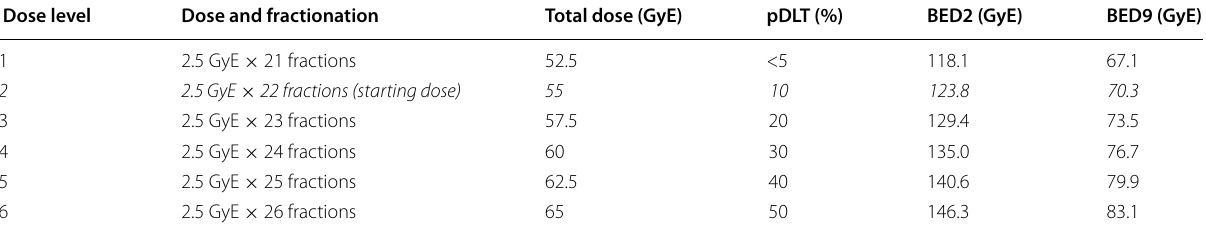
The starting dose of the trial is at 2.5 GyE 22 (in italics) × CIRT carbon-ion radiotherapy, GyE gray equivalent, pDLT probability of dose-limiting toxicities, BED biological effective dose, BED2 cumulative BED with an α/β ratio of 2, BED9 cumulative BED with an α/β ratio of 9